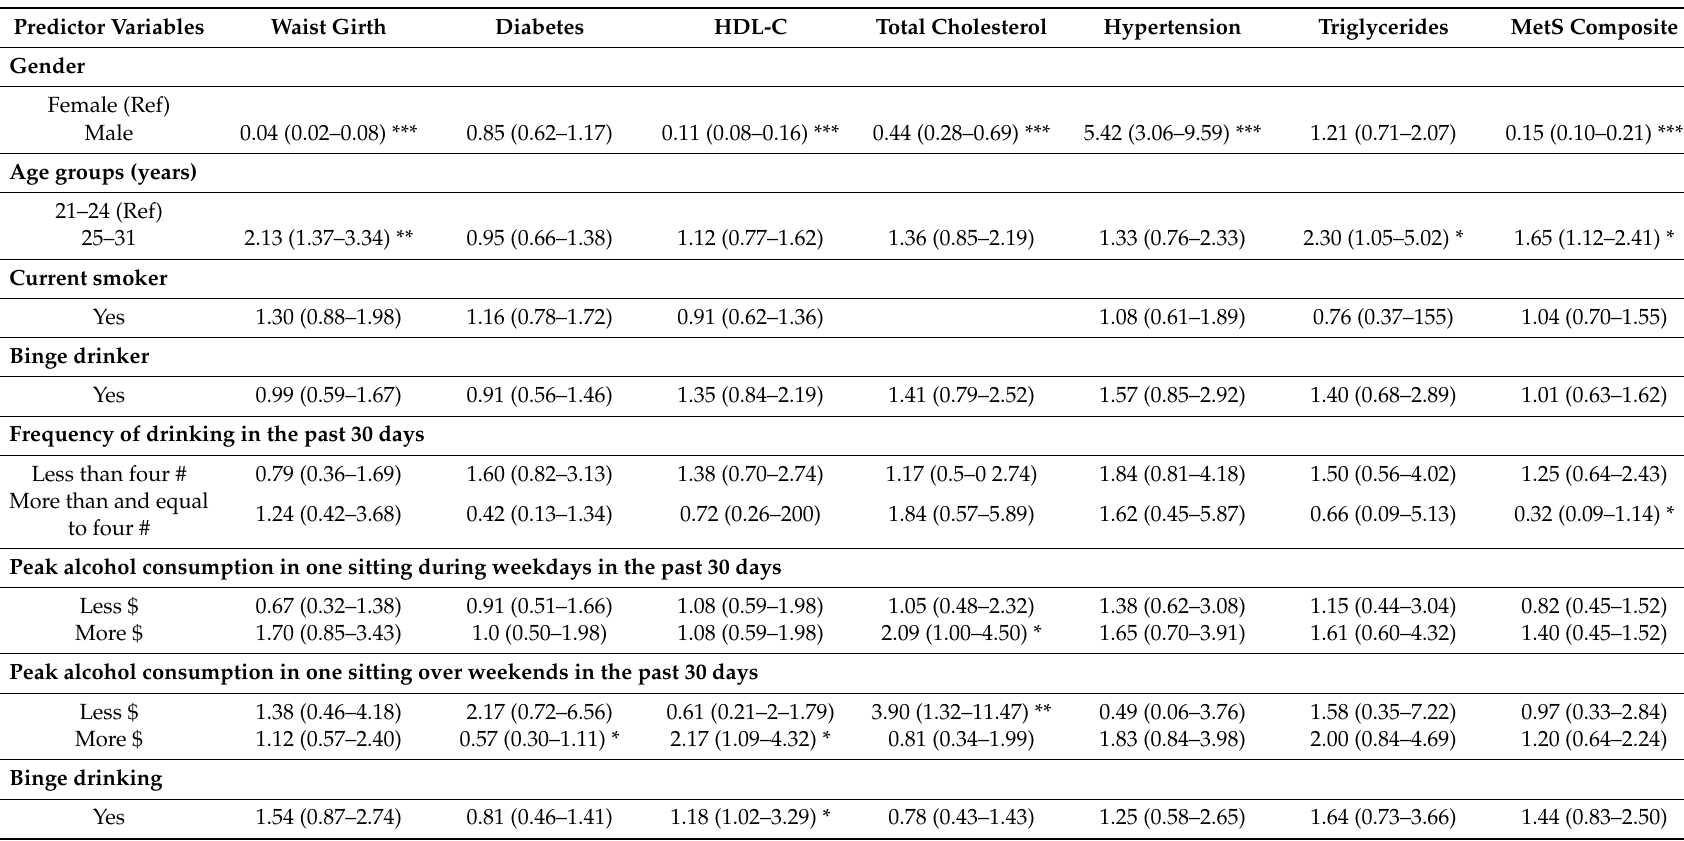
Table 3. Unadjusted associations between binge drinking, related factors, and components of metabolic syndrome among Ellisras young adults aged 21 to 31 years. Predictor